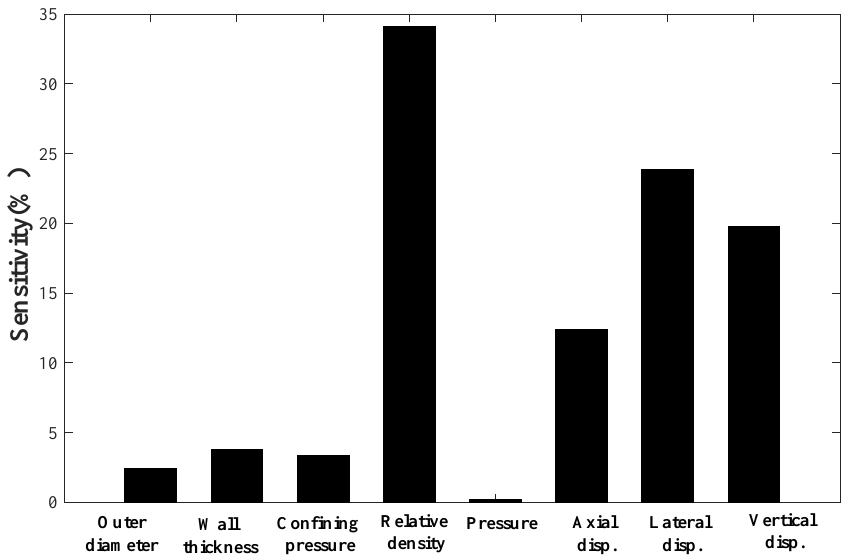
Figure 9. Absolute sensitivity values for various input parameters towards the peak compressive strains